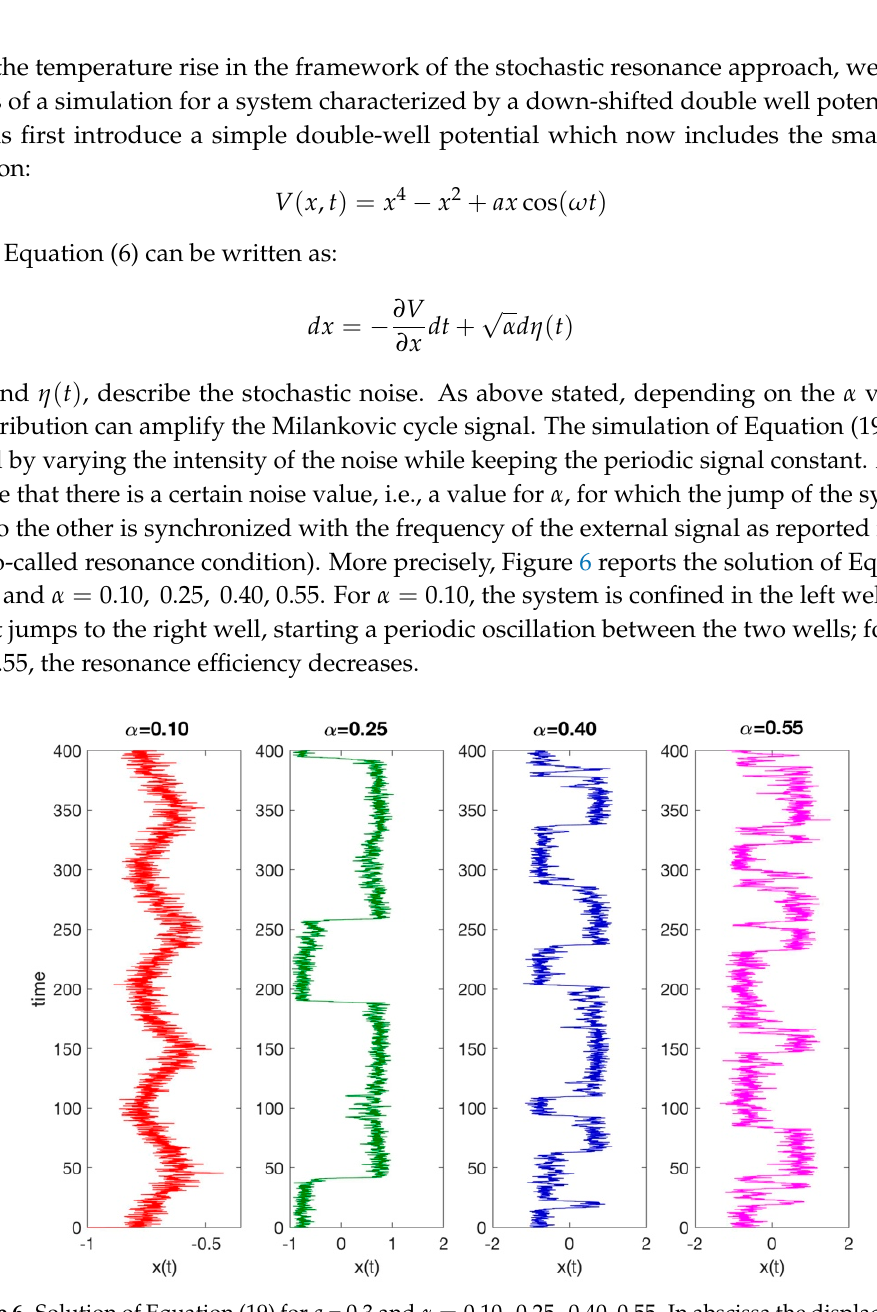
Figure 6. Solution of Equation (19) for a = 0.3 and α = 0.10, 0.25, 0.40, 0.55. In abscissa the displacement x(t) in arbitrary units and in ordinate time steps is reported. For α = 0.10, the system is confined in the left well, while for α = 0.25 it jumps to the right well, starting a periodic oscillation between the two wells; for α = 0.40 and α = 0.55, the resonance efficiency decreases.